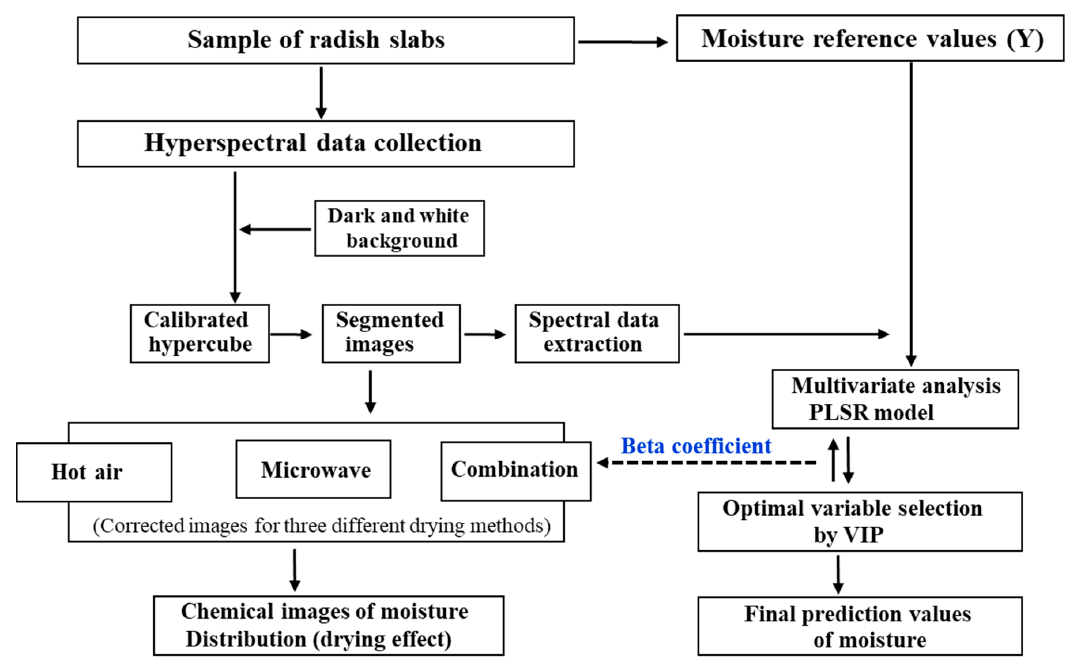
Figure 3. Schematic diagram illustrating the workflow of the data processing.